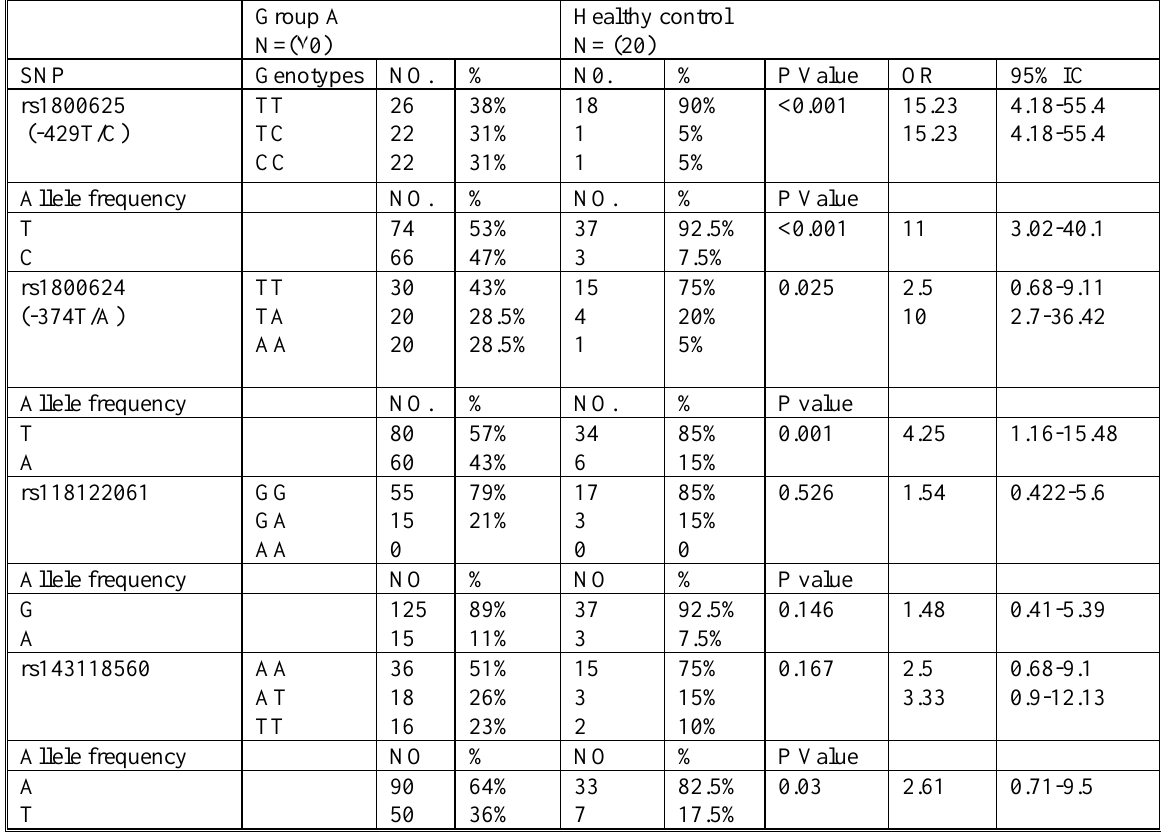
Table 3. Comparison between genotypes and alleles frequency of RAGE polymorphism of the study entire group